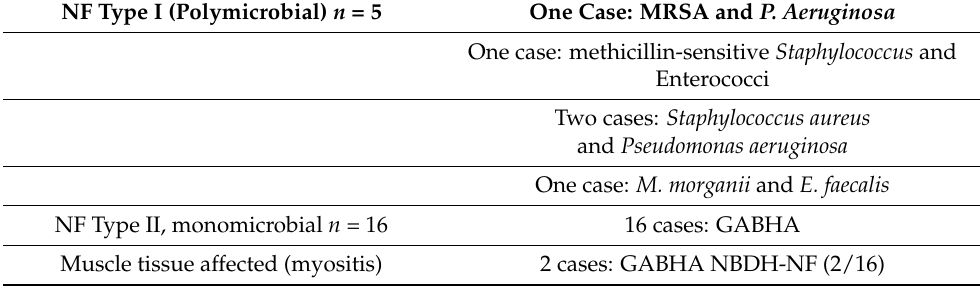
Table 2. Pathogenic agents.